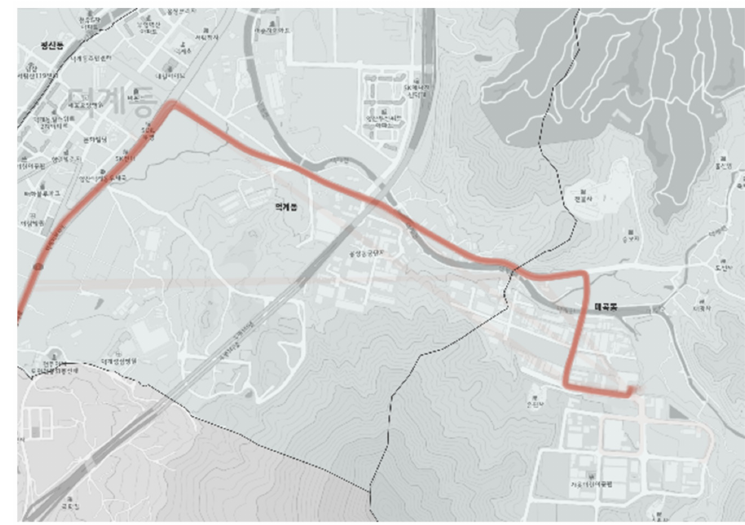
Figure 14. Actual driving record of city-type bus No. 3.